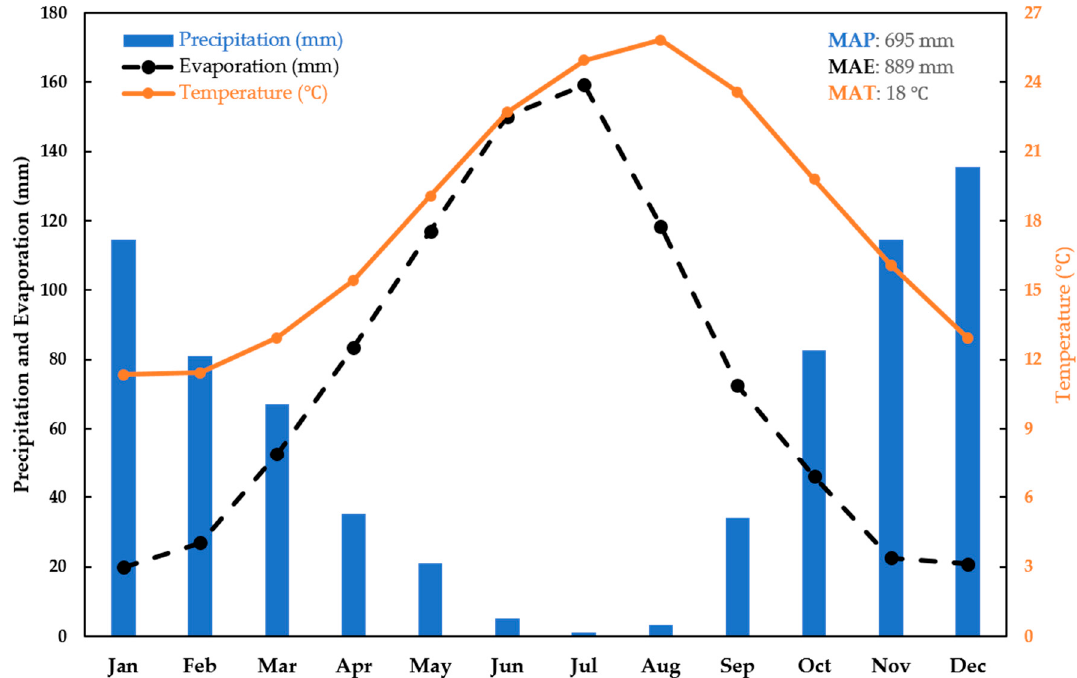
Figure 6. Monthly mean precipitation (MAP), evaporation rate (MAE) and temperature (MAT) for the period 1956–2011. Mean annual values for the whole study period are also reported in the top-right of the figure.